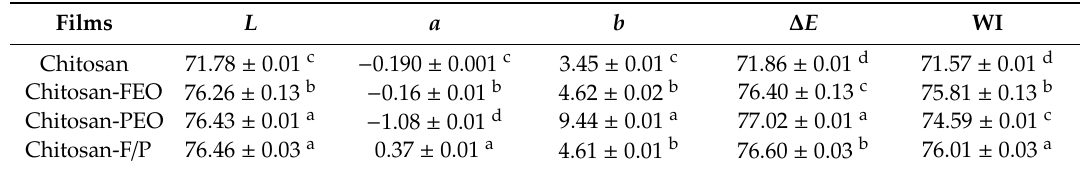
Table 3. Color parameters including L , a , b , ∆ E , and WI of the Chitosan, Chitosan-FEO, Chitosan-PEO, and Chitosan-F / P